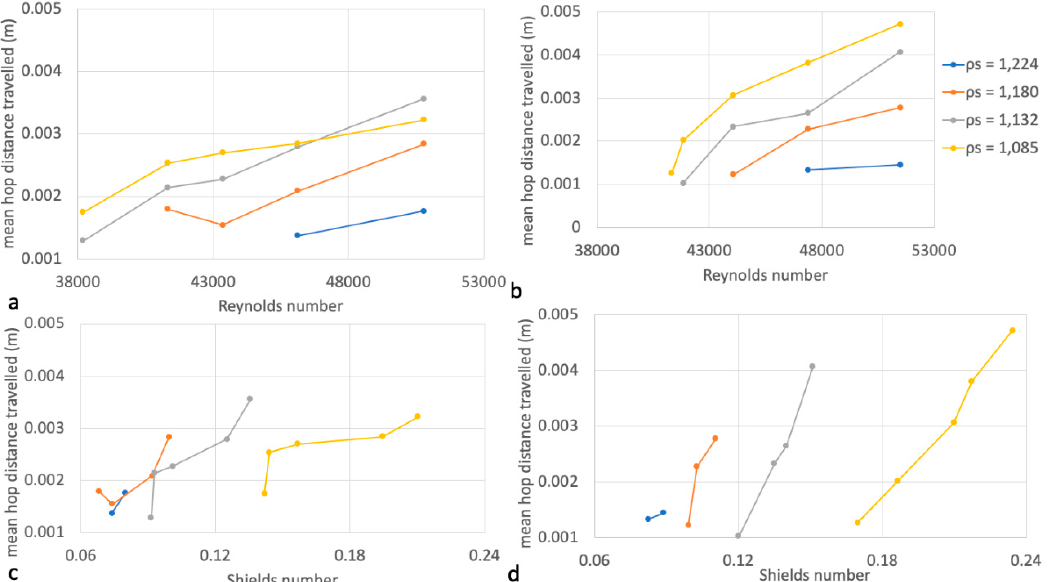
Figure 12. Mean hop distance travelled, for different instrumented particle densities: ( a ) against Reynolds number, for bed surface A, ( b ) against Reynolds number, for bed surface B, ( c ) against Reynolds number, for bed surface A, and ( d ) against Reynolds number, for bed surface B.